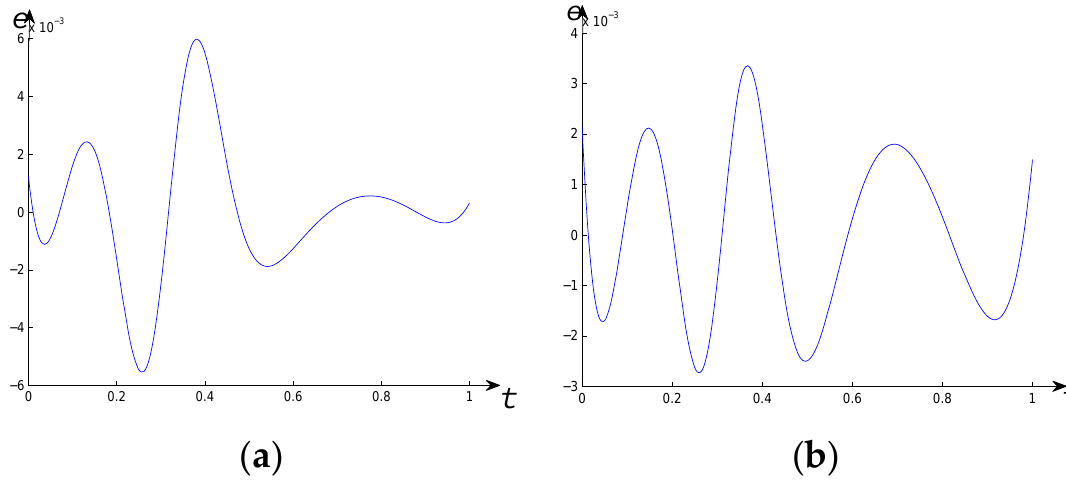
( b ) Figure 4. Error curves of different approximation methods. ( a ) Interpolating algorithm; ( b ) Algorithm in this paper after the second iteration. Lee’s method [12] is regarded as classical in offset approximation, which is simple and highly precise. Ahn et al. made an improvement of their work to reduce the degree of the approximation